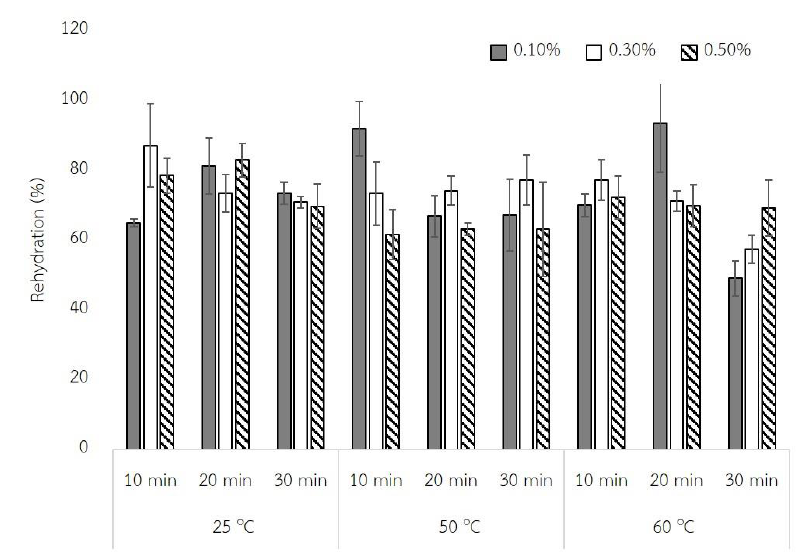
Figure 1. Rehydration capacity of each QBJR sample.